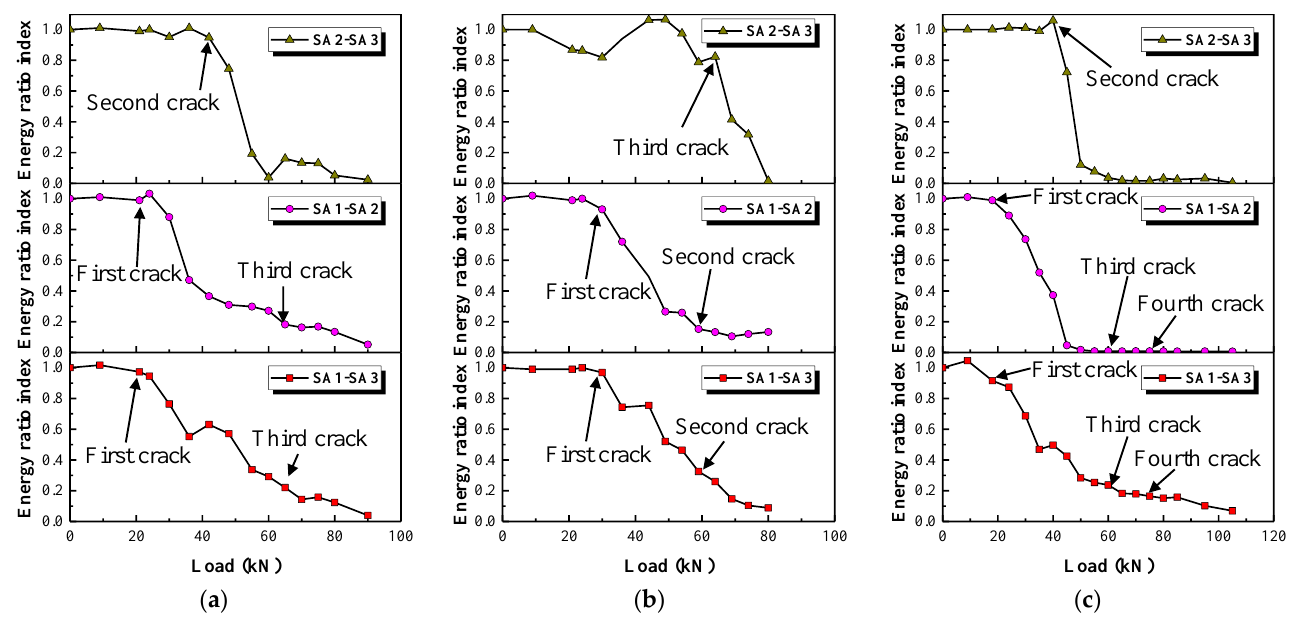
Figure 29. ERI values of three test specimens. ( a ) Test specimen G1; ( b ) Test specimen G3; ( c ) Test specimen S1.